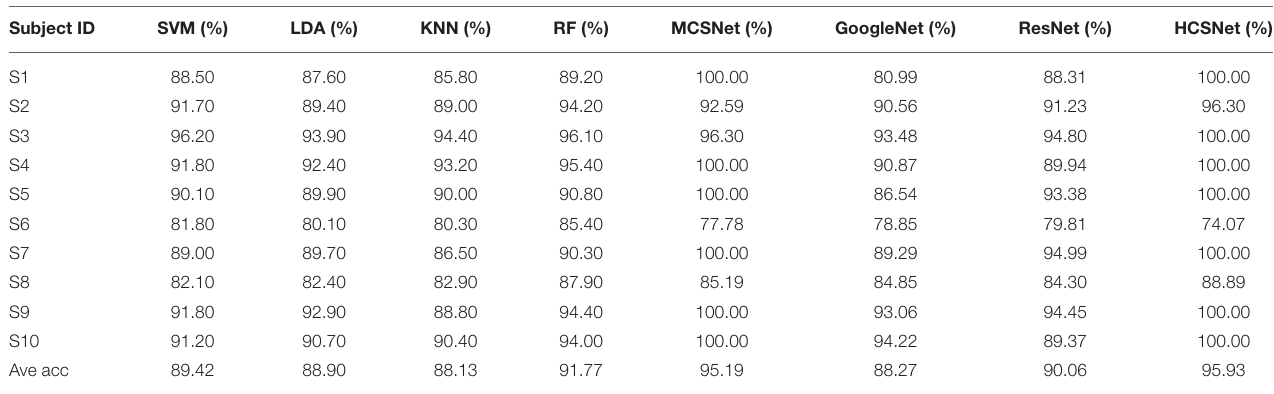
TABLE 1 | Within-subject movement prediction performance (Test set